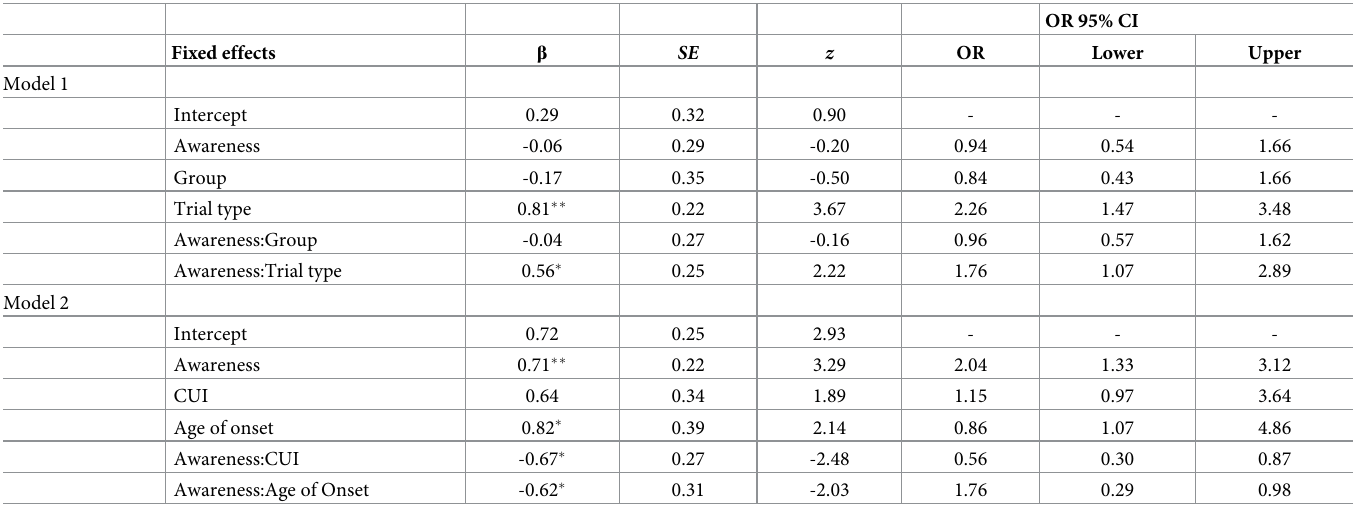
Table 4. Mixed effects logistic models predicting post-error inhibition